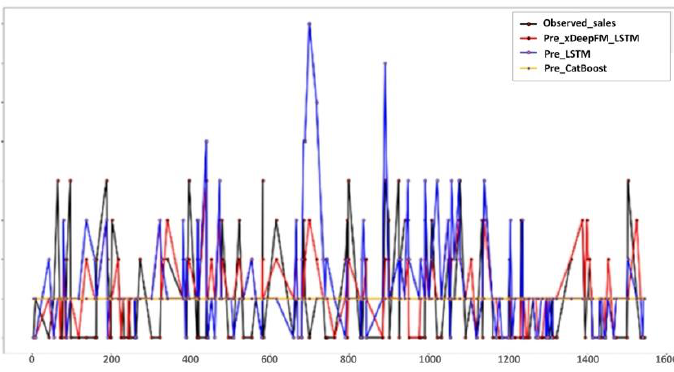
Figure 4. Comparison of the prediction performance of each algorithm.